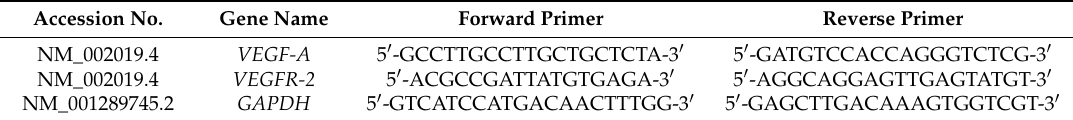
Table 1. Primer sequences used for semi-quantitative reverse transcription